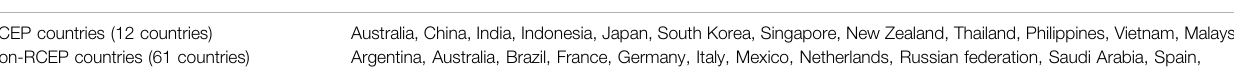
TABLE A1 | The speci fi c countries of RCEP and non-RCEP countries. Region Provinces RCEP countries (12